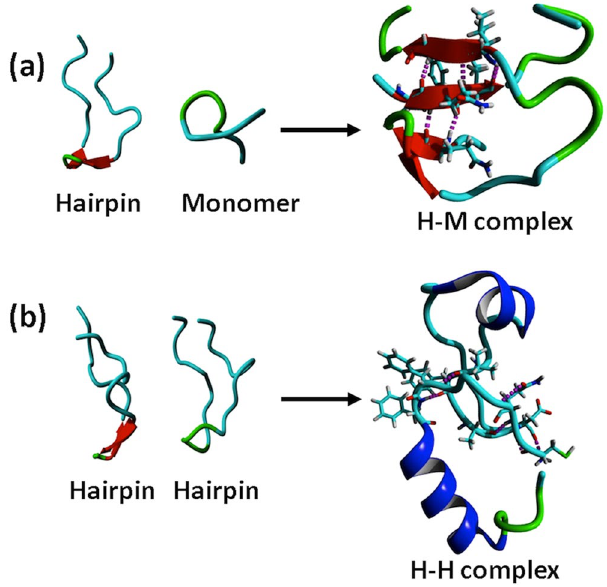
Figure 4. Structural investigation by molecular dynamics simulation; ( a ) Initial structure of H-M complex (left) and the most likely conformation for the H-M complex (right). ( b ) H-H complexes; initial structure (left) and the predicted most likely structure